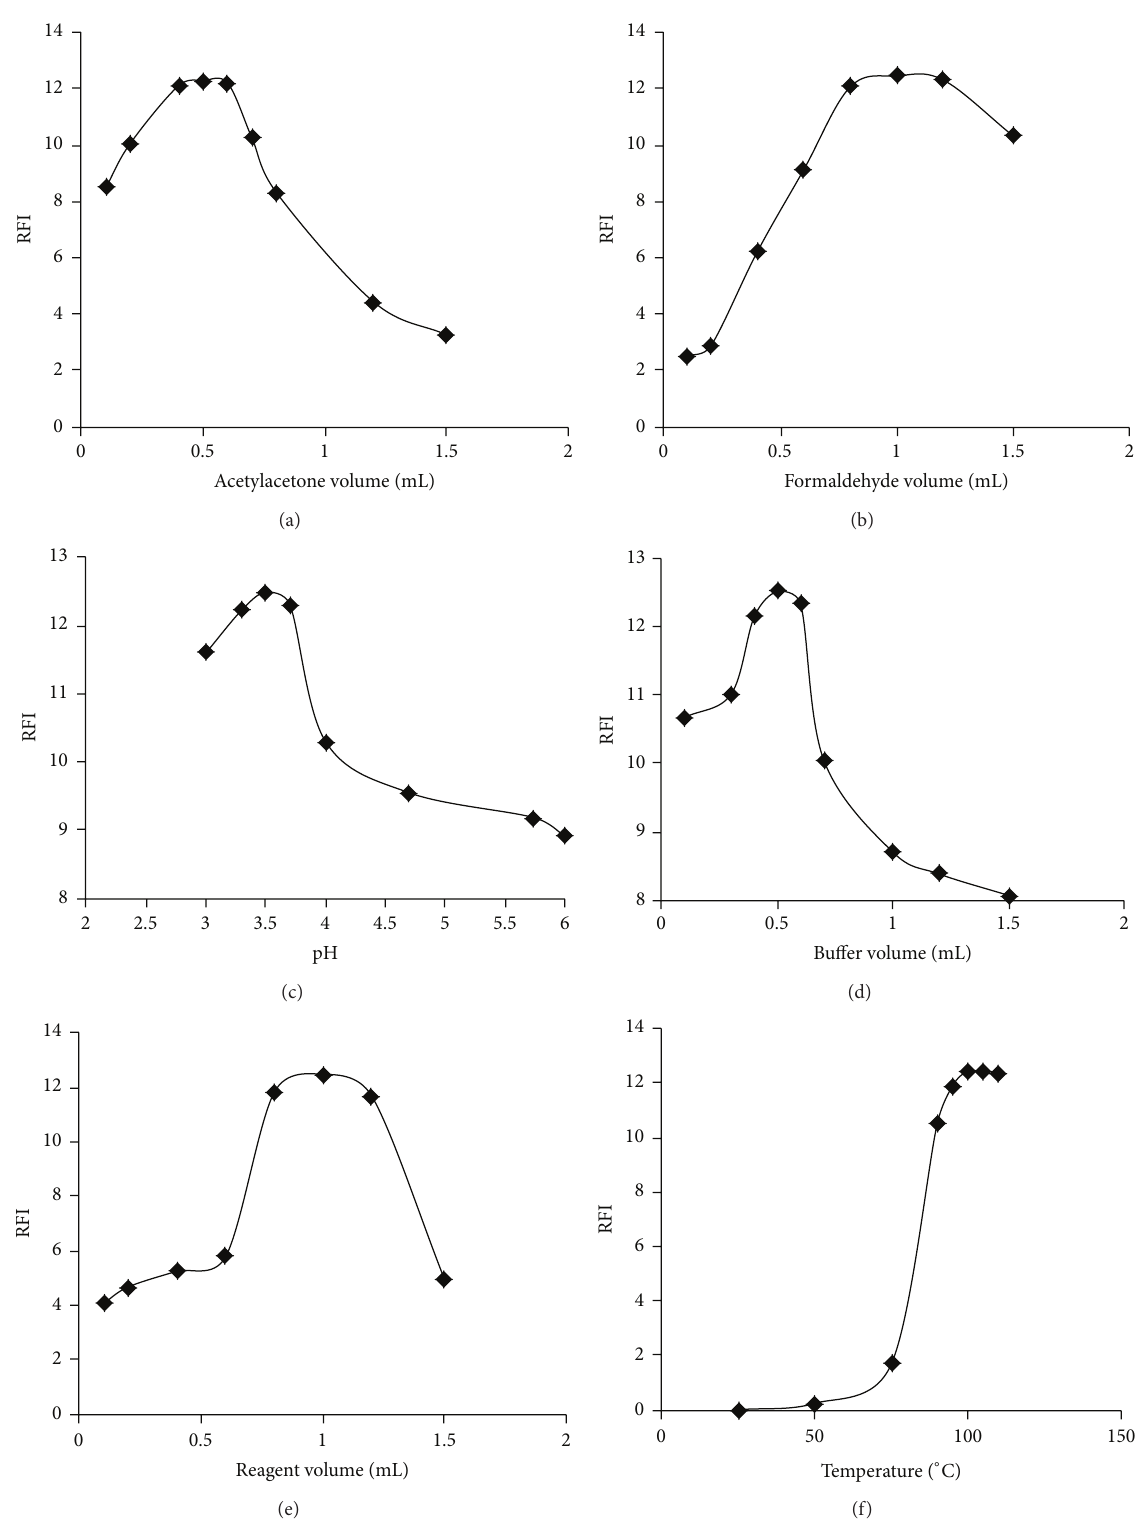
Figure 5: Effect of the different optimization factors. (a) Volume of acetylacetone, (b) volume of formaldehyde, (c) pH, (d) volume of buffer, (e) volume of reagent components, and (f) temperature on RFI using Hantzsch